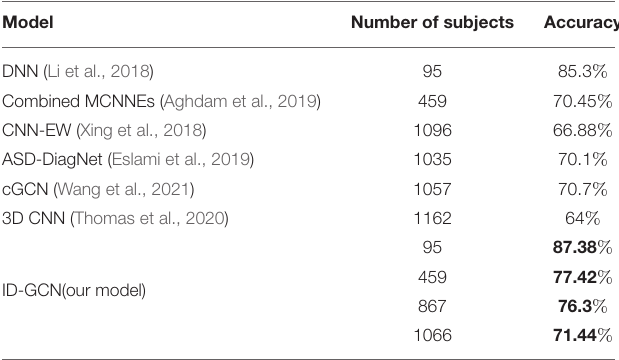
TABLE 3 | Comparison with other SOTA